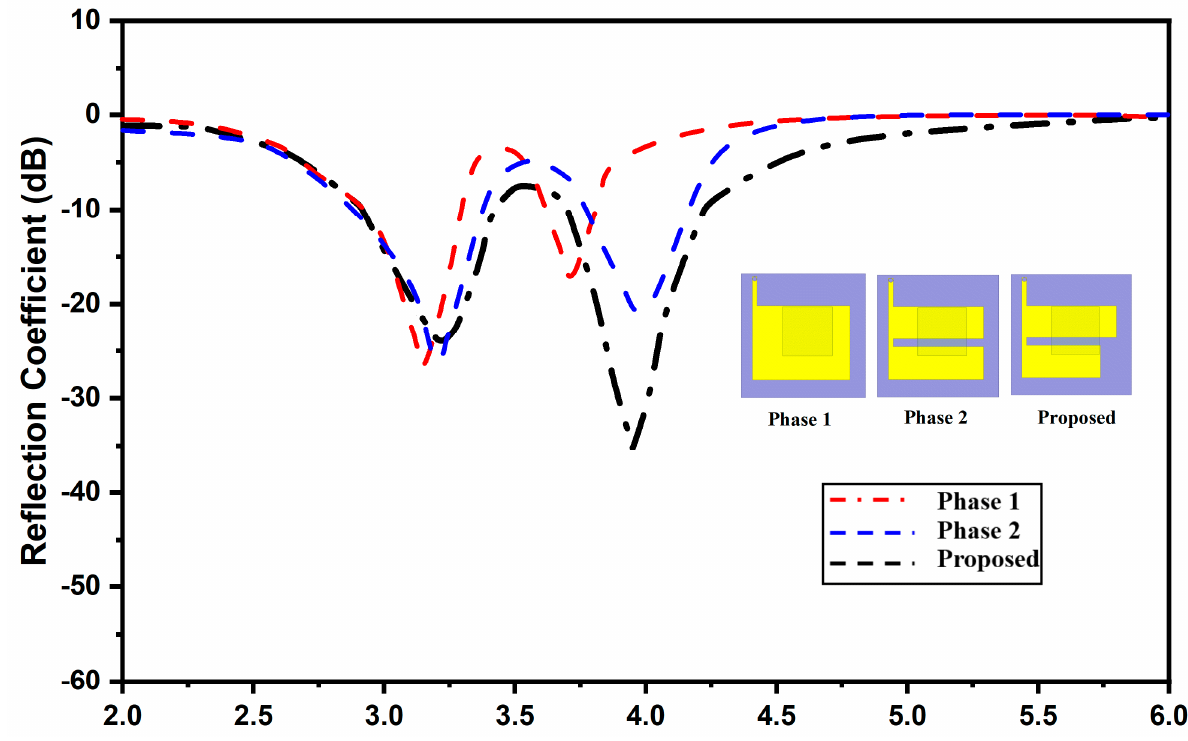
Figure 2. Antenna development phases.